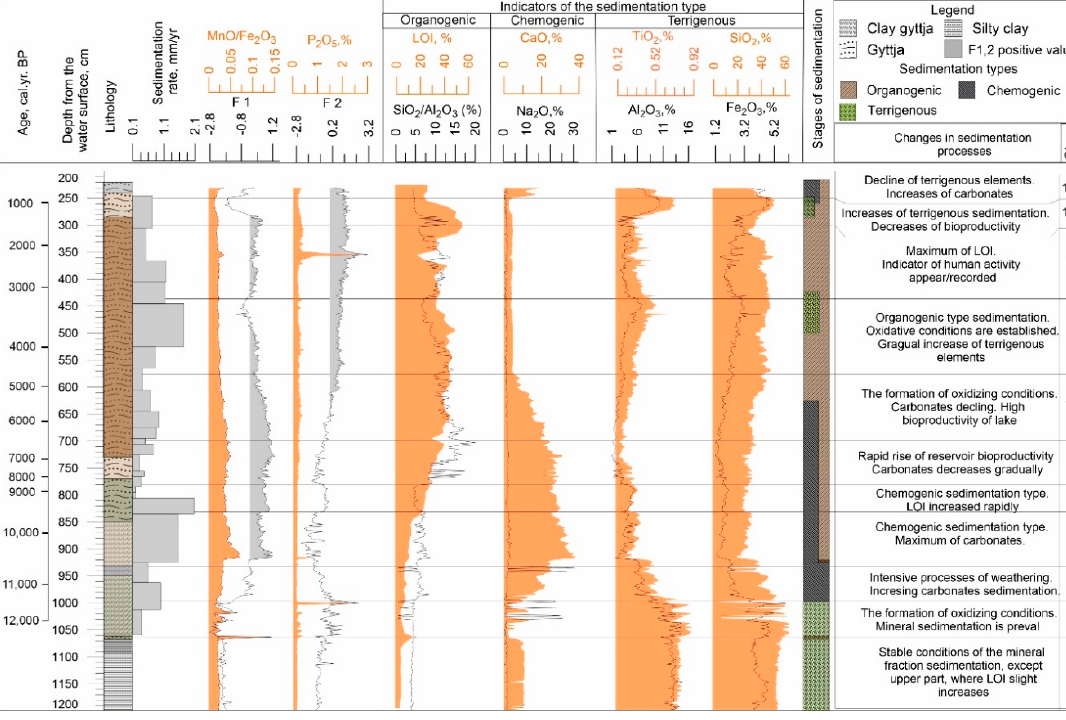
Figure 5. The reconstruction of sedimentation changes.